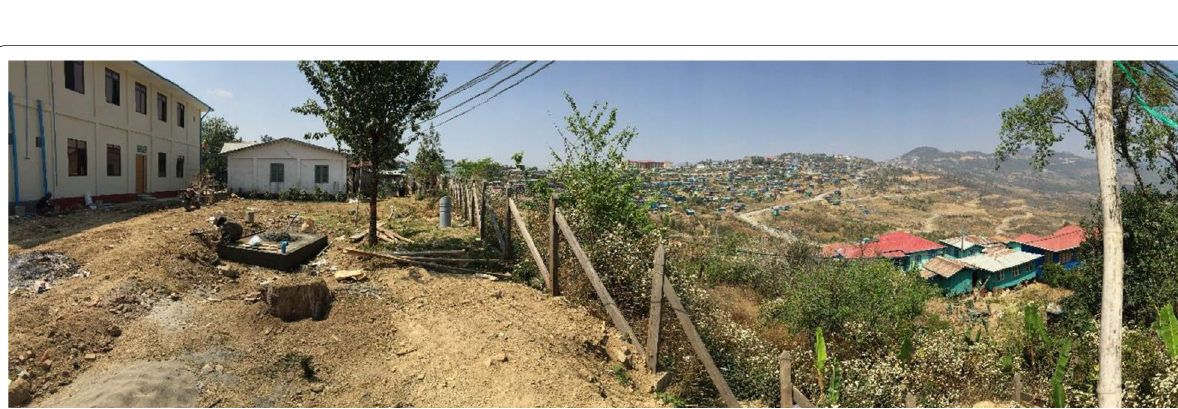
Fig. 5 General view of the slope at Keisi-Khaikam, the buildings on the left would be impacted by any retrogressive slope failure in the slope to the right (i.e., the chain fence in the centre of the photo is located at the slope